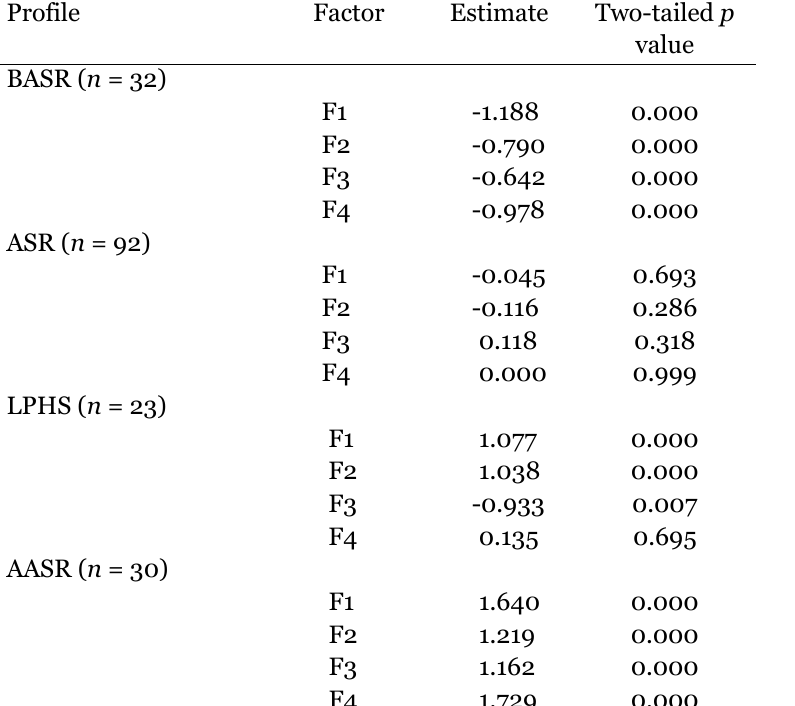
Mean Factor Scores by Latent Profile